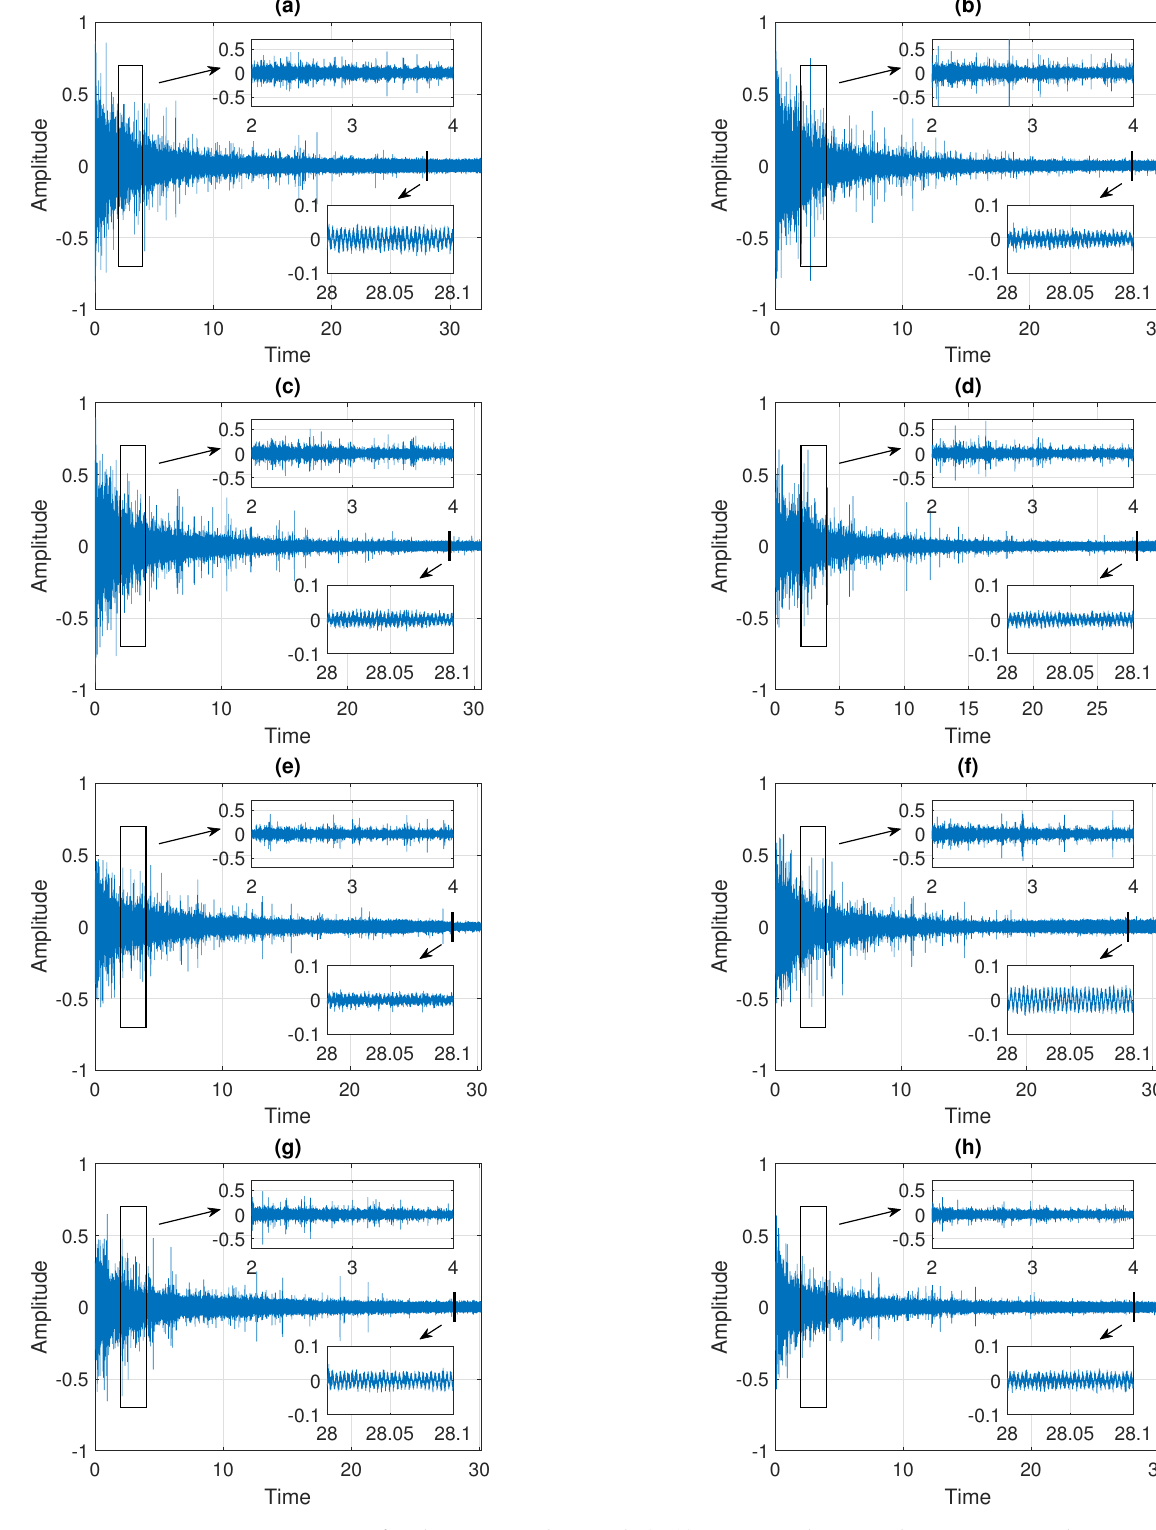
Figure 2. Trajectories of eight raw signals. Panels ( a – h ) correspond to Signals 1–8,